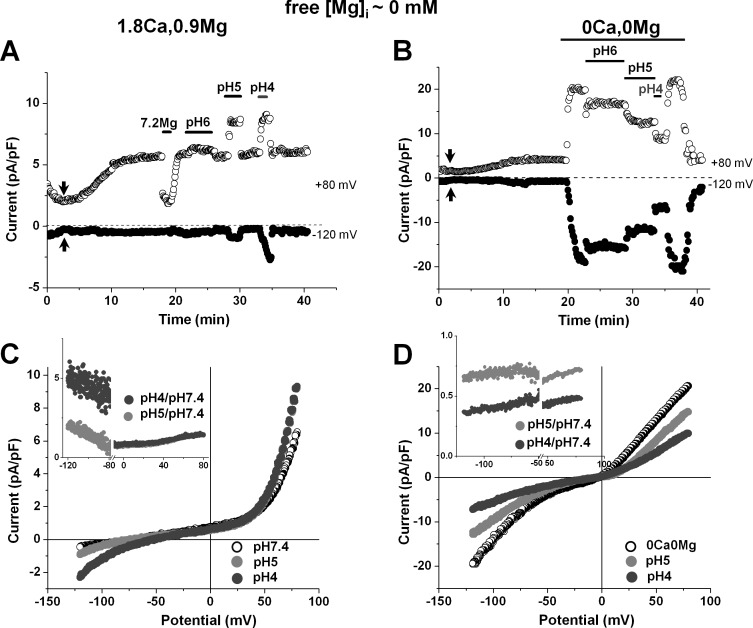
Effect of extracellular pH on the TRPM7 current in physiological and nominally divalent-free medium.(A-B) Currents recorded at +80 mV and –120 mV from two different human atrial cardiomyocytes before and during acidification of extracellular solutions either in the presence (A) or in the absence of extracellular divalent cations (B). Periods of exposure to acidic pH and nominally divalent-free solutions are indicated by horizontal bars. (C-D) Current-voltage relationships under steady-state conditions obtained using voltage ramps from +80 mV to –120 mV in the same cells as in A and B, respectively. (Insets in C-D) Ratios between TRPM7 currents recorded under various pHo conditions over the current at pH 7.4. Breaks were made in the graph for potentials were currents at pH 7.4 were close to 0, making the ratio inaccurate. Notice that both the inward and outward currents are potentiated by acidic pH when perfusing with extracellular solution containing divalent cations, whereas they were reduced in nominally divalent-free medium.